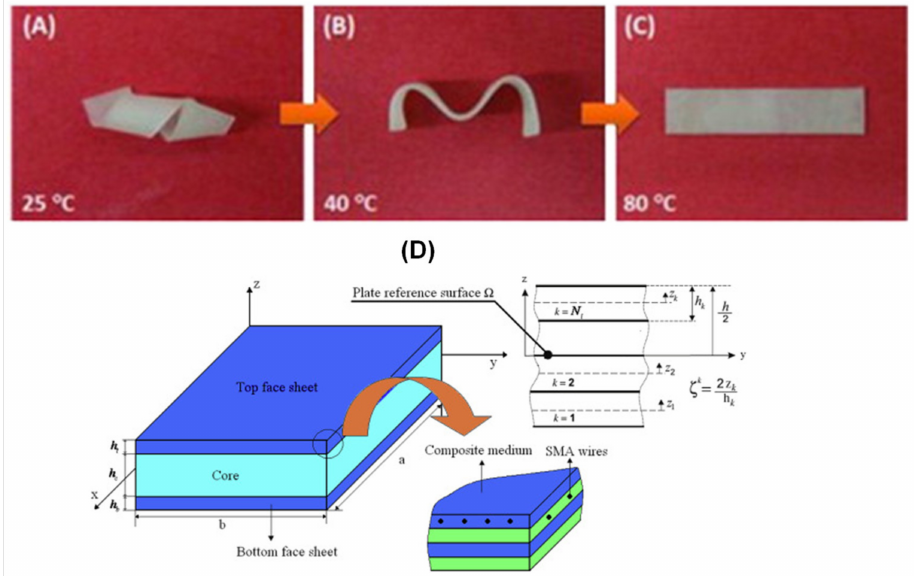
Figure 12. The sequential recovery of the epoxy/polycaprolactone composite ( A ) Deformation from a temporary shape, ( B ) Deformation to temporary shape, ( C ) Deformation to a permanent shape [86], ( D ) Geometry and coordinate systems of sandwich plate with SMA hybrid composite faces